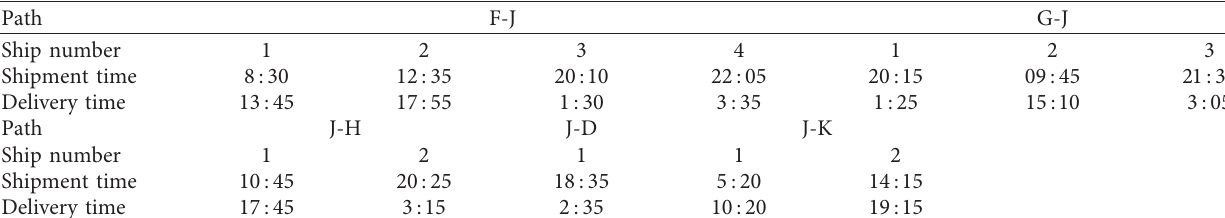
Table 3: Timetable of sea transport.